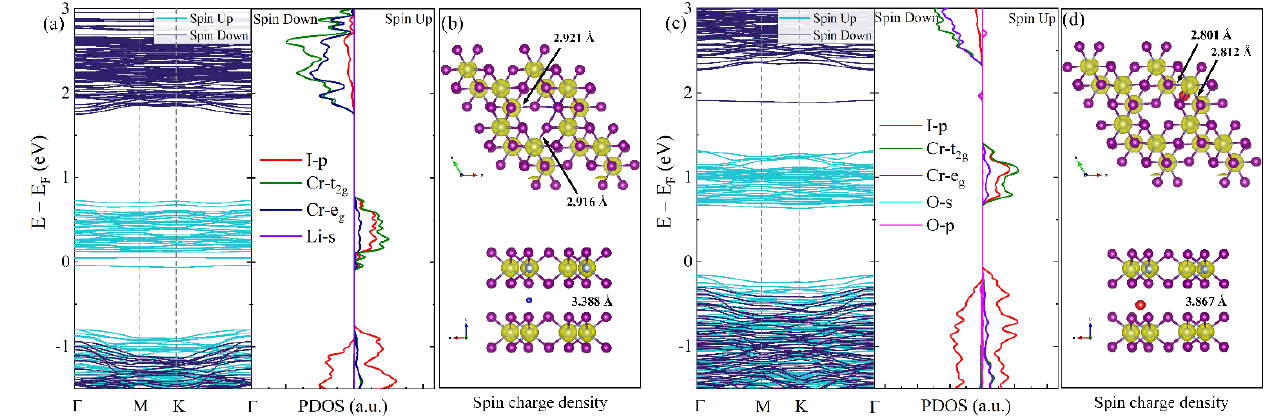
Figure 2. Band structures and PDOS of ( a ) Li and ( c ) O intercalated of 2 × 2 supercell. The ( b ) and ( d ) is the spin charge density and crystal structure parameters. The isosurface value is 0.03 e/Bohr 3 . The band structures and PDOS near the Fermi level of Li and O intercalated structures are drawn in Figure 2. It was found that both Li and O intercalation in the CrI 3 bilayer exhibited spin-polarized states, and the conduction band minimum (CBM) and the valence band maximum (VBM) were both donated from the spin-up state. For the Li-intercalated CrI 3 , the Fermi level was pushed up and across the spin-polarized conduction bands. As a result, the spin-up channel was metallic, while spin-down sub-band remained a sizable band gap of 2.69 eV, which led to the half-metallic character. Unlike the Li intercalated structure, the O intercalated CrI 3 bilayer maintained a semiconductor, while the band gap was reduced to 0.79 eV. The PDOS of both Li and O intercalated CrI 3 illustrates that the VBM is mostly contributed by p orbitals of I and the CBM is mostly contributed by d orbitals of Cr. According to the spin charge density in Figure 2b,d, the magnetic mo- ment is provided by Cr atoms. The average magnetic moments of Cr in the Li and O in- tercalated CrI 3 bilayer were 3.43 and 3.38 µB, respectively. In addition, the maximum mag- netic moments were 3.58 and 3.45 µB, respectively. In short, these results revealed that intercalation had a remarkable influence on the electronic and magnetic characteristics of the CrI 3 bilayer.